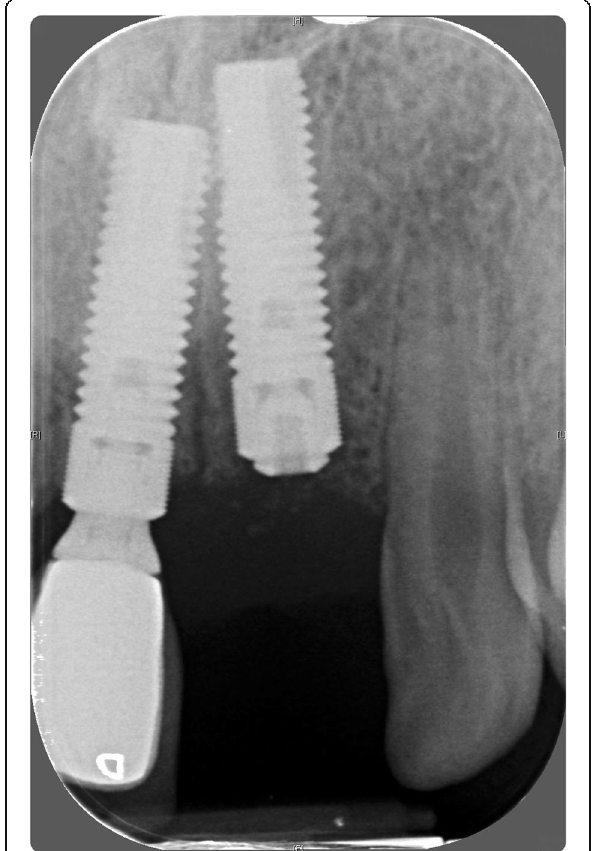
Fig. 8 Placement confirmation. Radiograph of fixture in 21 position confirming angulation which is not ideal but acceptable